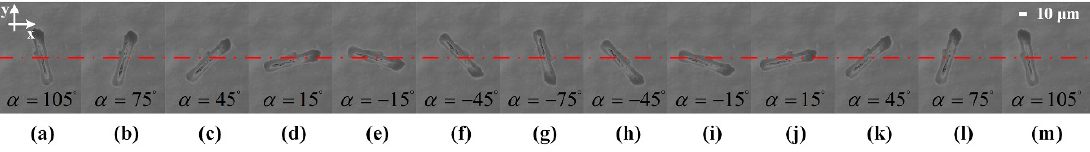
Figure 10. Rotation with 5° angle interval. Figure 11. Alternating rotation by inverting the adjustment of the transducer excitation. ( a – g ) show a half-cycle clockwise rotation with a 30 ◦ interval angle and ( g – m ) is the reverse rotation with the same interval.